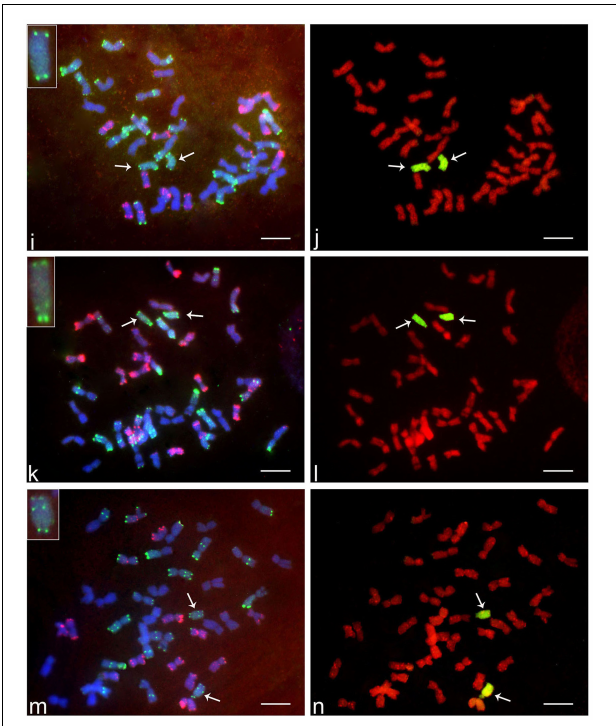
FIGURE 2 | FISH and GISH on the somatic metaphase chromosomes of six addition lines and their wheat parent ‘Alcedo.’ The left side of figure (a,c,e,g,i,k,m) are FISH results, where red indicates pAs1 hybridization sites detected by rhodamine fluorescence and green indicates pSc119.2 hybridization sites detected by FITC fluorescence. The right sides of figure (b,d,f,h,j,l,n) are GISH results, where green indicates Aegilops markgrafii chromatin detected by FITC fluorescence. a and b , Alcedo; c and d , AI(B); e and f , AII(C); g and h , AIII(D); i and j , AV(E); k and l , AIV(F); m and n , AVIII(G). Arrows indicate the alien chromosomes. Bar represents 10 µ